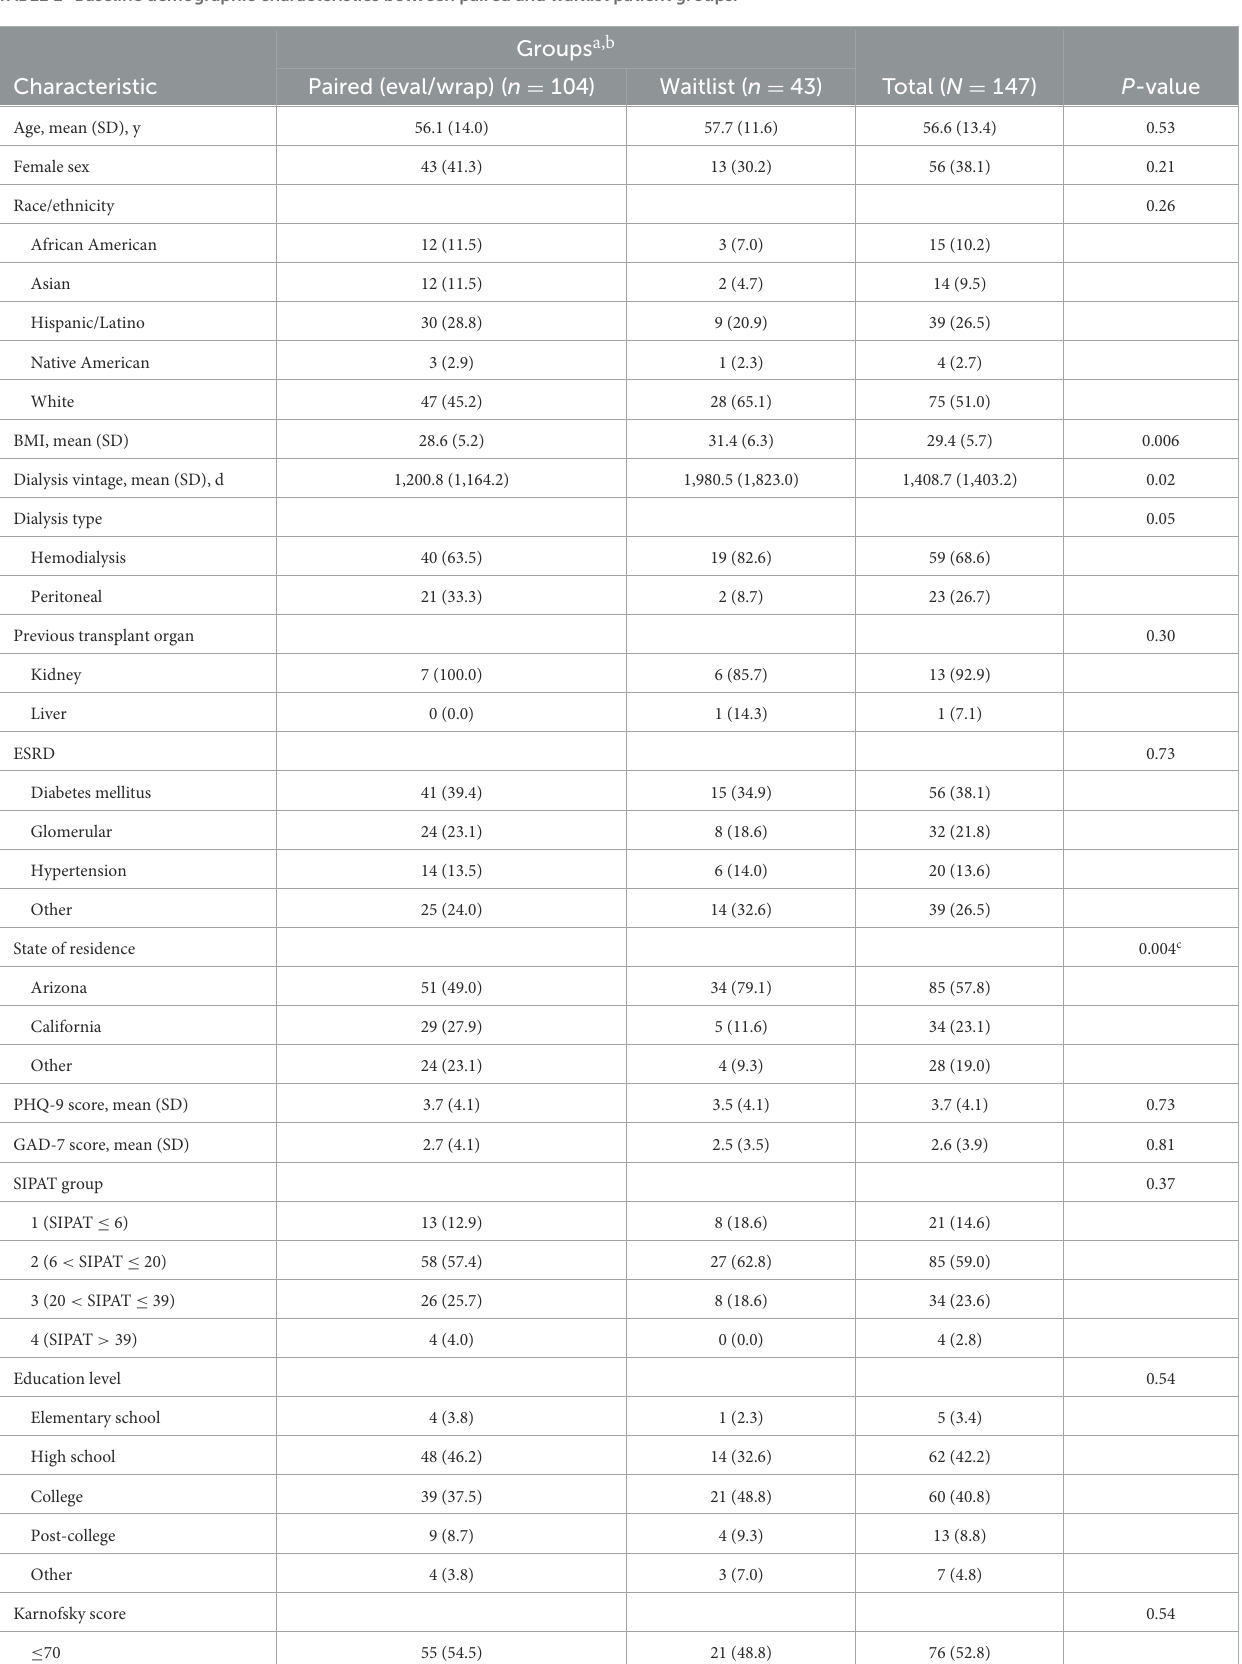
TABLE 1 Baseline demographic characteristics between paired and waitlist patient groups.